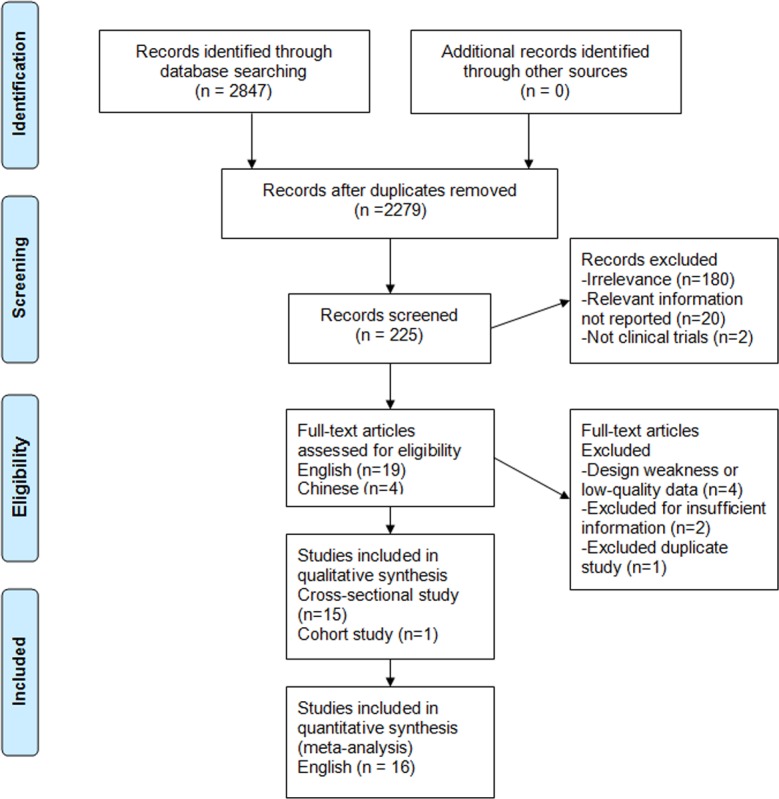
Search strategy and flow of information relative to the meta-analysis.